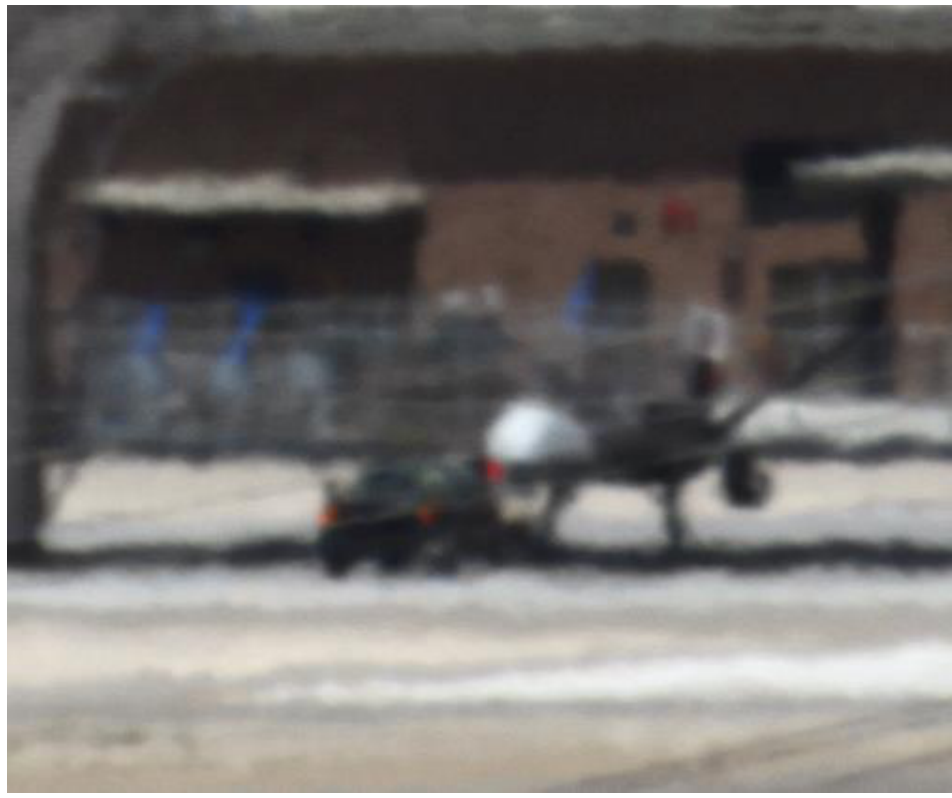
Trevor Paglen, Reaper Drone (Indian Springs, NV, Distance ~ 2 miles) , from the Limit Telephotography series, 2010. C-print, 30 x 36 in. Copyright Trevor Paglen, courtesy the artist and Metro Pictures, New York; Altman Siegel, San